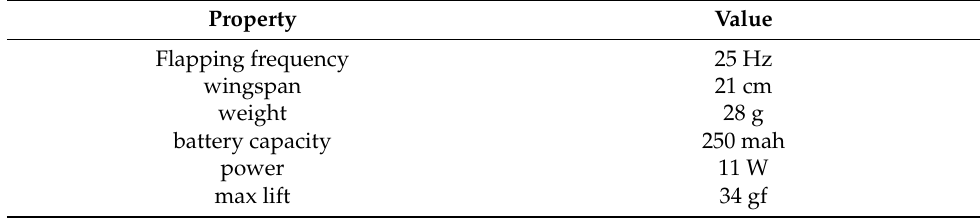
Figure 10. The physical drawing of the prototype. Figure 11. The mass distribution of the FMAV.